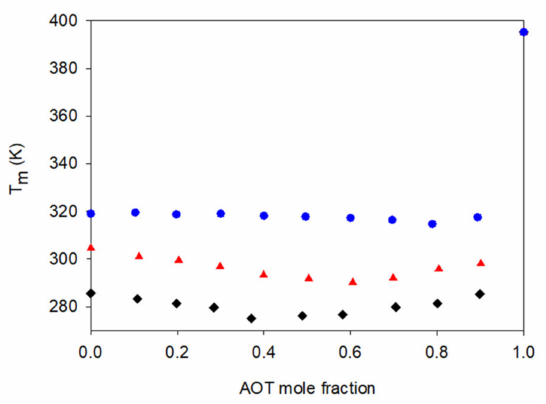
Figure 1. Melting curves of the systems AOT + PEG: ● AOT + PEG-2000, ▲ AOT + PEG-1000, ◆ AOT +